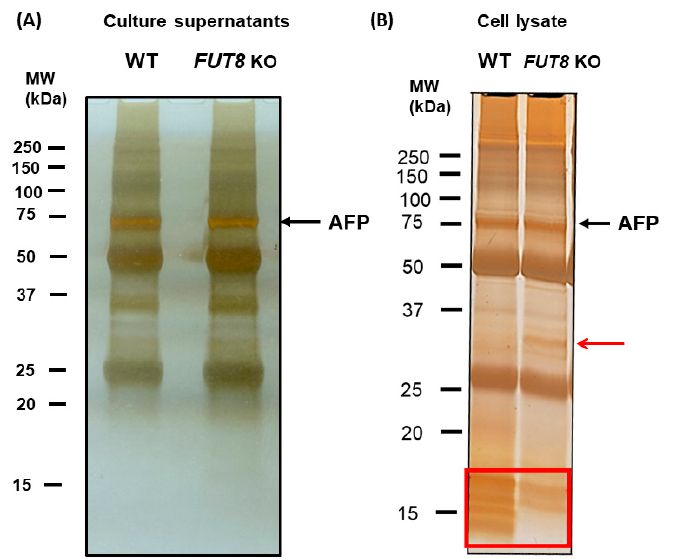
Figure 2. Silver staining of immunoprecipitated products from WT and FUT8 -KO HepG2 cells. ( A ) The silver-stained gel of immunoprecipitated product with anti-AFP antibody using culture supernatants of WT and FUT8 -KO HepG2 cells. ( B ) The silver-stained gel of immunoprecipitated product with anti-AFP antibody using cell lysates of WT and FUT8 -KO HepG2 cells. Red arrows indicate bands specifically detected in FUT8 KO samples. Additionally, a red-lined square indicates a group of bands strongly observed in the wild type.